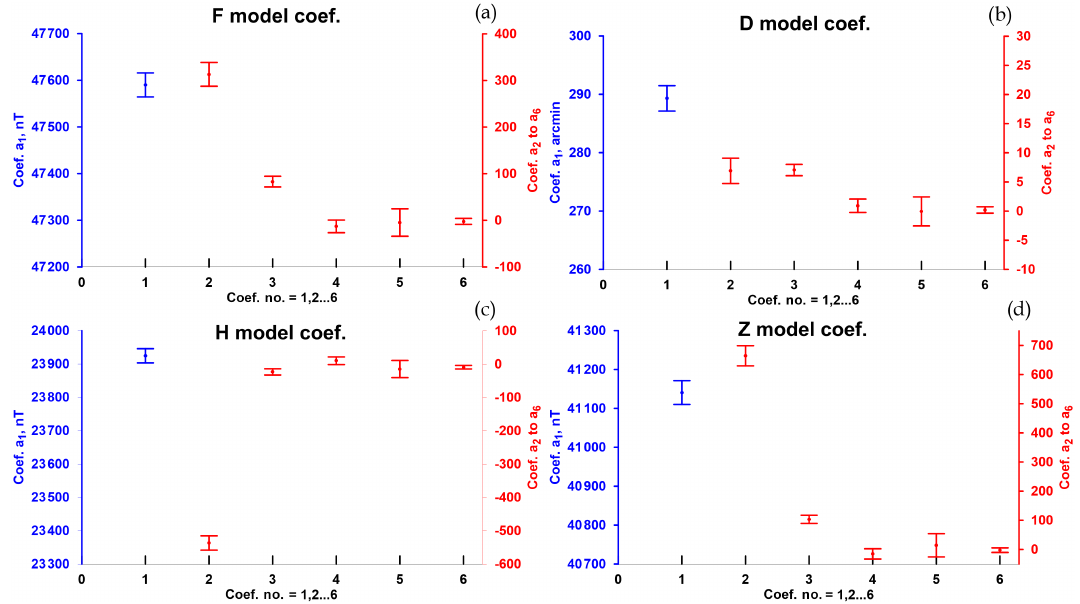
Figure 4. Confidence intervals of the empirically determined statistical estimate of the coefficients a 1 ,a 2 ,...,a 6 having minimum variance for each field element (a) F (nT), (b) D (arcmin), (c) H (nT) and (d) Z (nT). Left axis shows the value of the first coefficient a 1 in the respective units (nT for H , Z and F or arcmin for D ). Right axis shows the values of the a 2 ,a 3 ,...,a 6